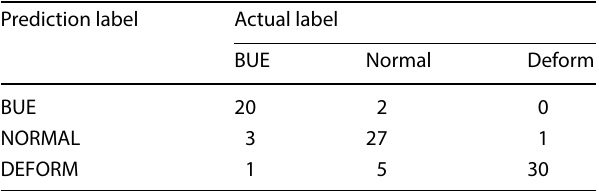
Table 4 Base model confusion matrix Prediction